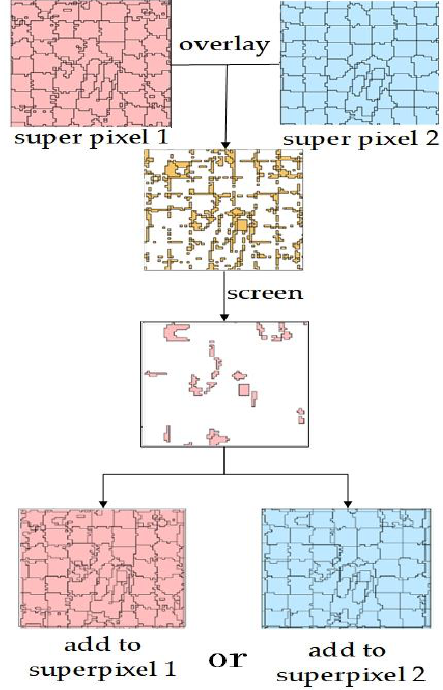
Figure 2. Overlay analysis flow chart.